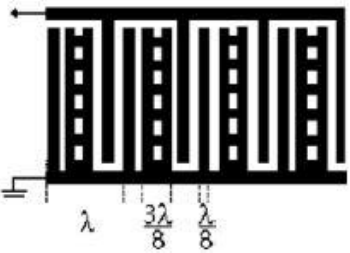
Figure 13. Schematic representation of the DART electrode configuration [2].